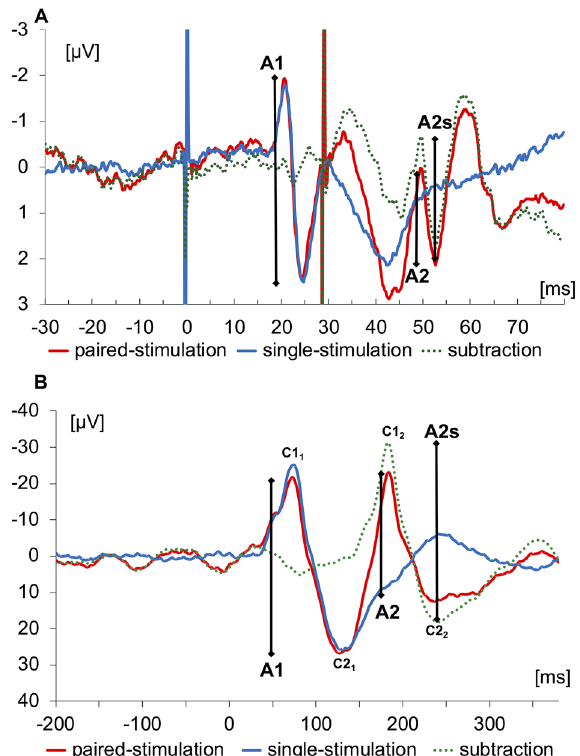
Figure 1. Analysis of paired-stimulation evoked potentials. ( A ) Somatosensory evoked potentials (SEP) recorded over CP3 after single (blue trace) and paired-stimulation with an ISI of 30 ms (red trace) of right median nerve. The dotted green trace results from subtracting the single-stimulation trace from the paired- stimulation trace. The analysed amplitudes of the first response (A1) and second response (A2) of the N20- P25 component after paired-stimulation are marked by vertical bars; amplitudes of the second response after subtracting the response to a single stimulation are denoted as A2s. Artifacts resulting from electrical stimulation at 0 and 30 ms were truncated. ( B ) Visually evoked potentials (VEPs) recorded over cortical Oz of one subject after single (blue trace) and paired-stimulation with stimulation onset asynchrony (SOA) of 93 ms (red trace). The label C was used to characterize the positive and negative components of the first and second cortical response. The dotted green trace results from subtracting the single-stimulation trace from the paired- stimulation trace. The analysed amplitudes of the first response (A1 = C2 1 –C1 1 ) and second response (A2 = C2 2 – C1 2 ) amplitudes after paired stimulation are marked by vertical bars; amplitudes of the second response after subtracting the response to a single stimulation are labelled as